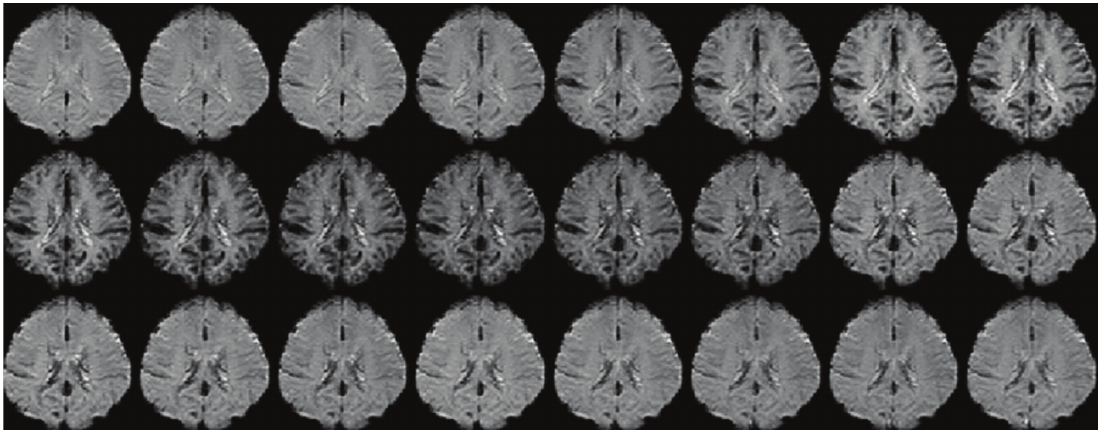
Figure 1: Perfusion MR images from a 39-year-old volunteer. Images encompass the first circulation (7–30, from left to right, top to bottom) at an upper slice